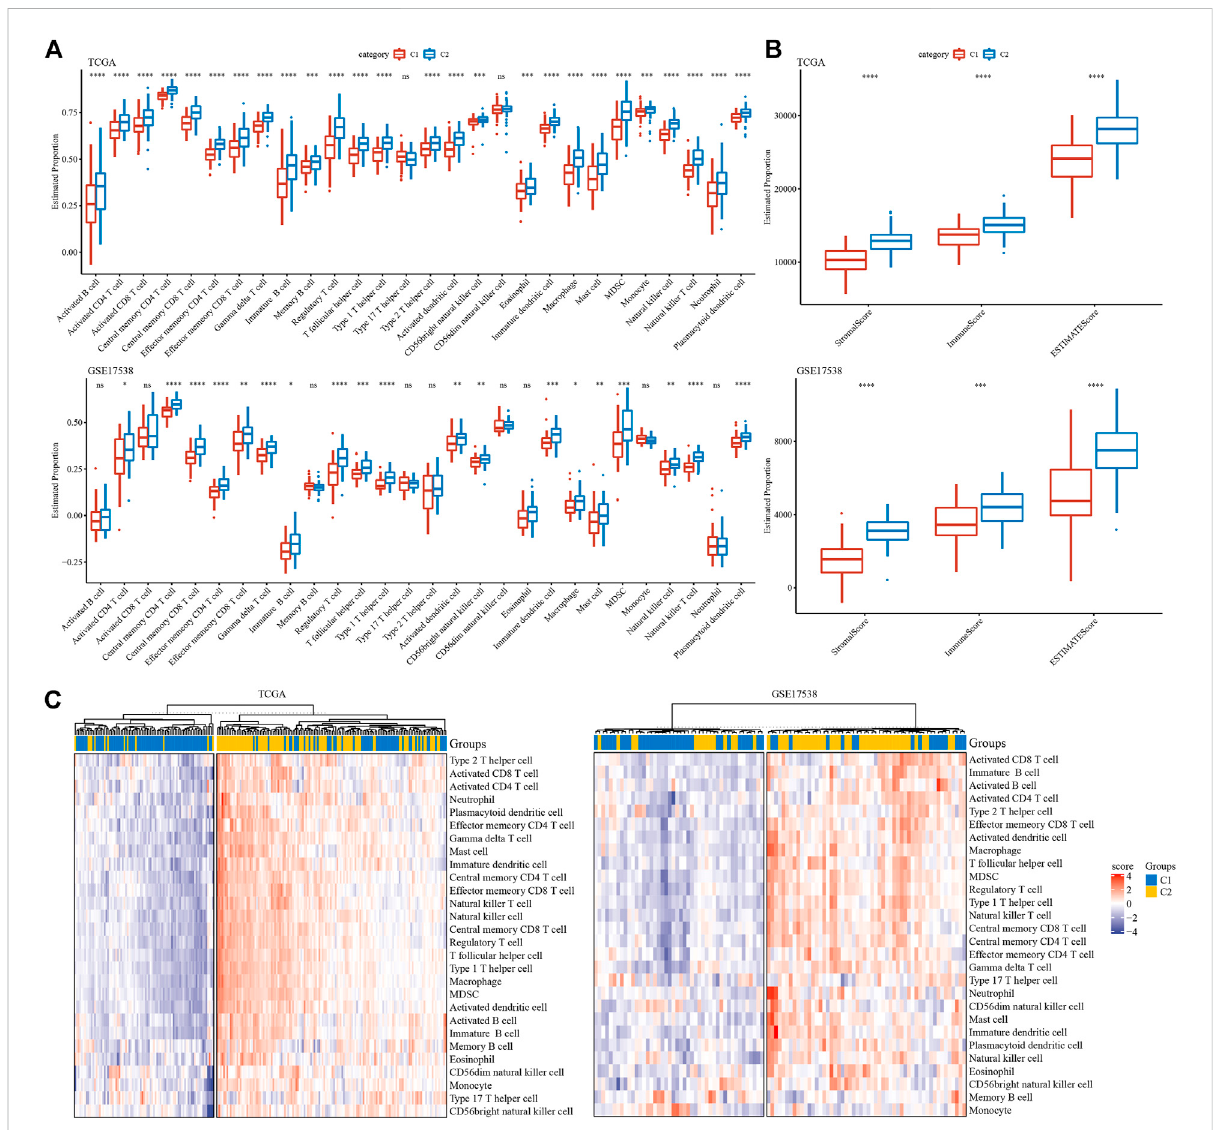
FIGURE 5 Tumor microenvironment of C1 and C2 subtypes (A) Estimated proportion of 28 immune cells in TCGA-COAD and GSE17538 cohorts. (B) Stromal score and immune score in TCGA-COAD and GSE17538 cohorts calculated by ESTIMATE. (C) Unsupervised consensus clustering based on genesignaturesofimmune cellsintwocohorts.Red andpurpleindicatesrelativelyhighandlow enrichment.Student t testwasconductedbetween two groups. ns, no signi fi cance. * p < 0.05, ** p < 0.01, *** p < 0.001, **** p <